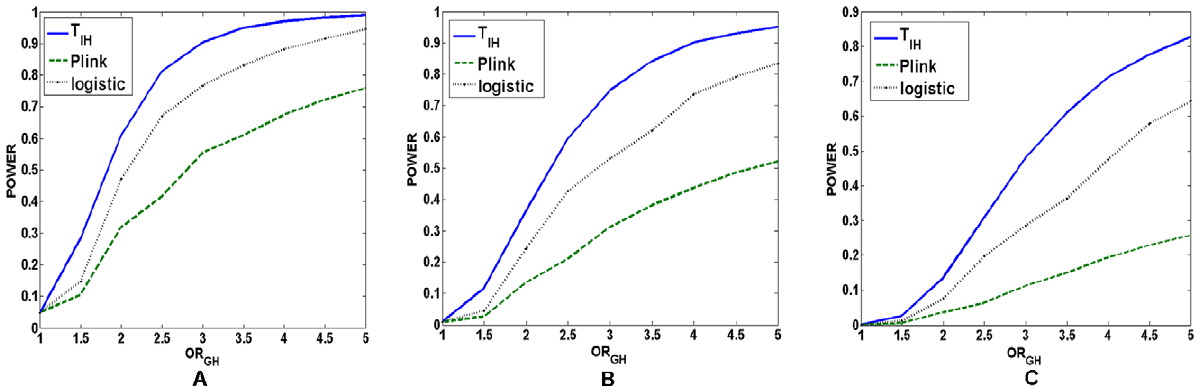
Figure 3. Power of the statistics for testing interaction between two linked loci under dominant disease model. (A) The power of the test statistic T IH , the ‘‘fast-epistasis’’ in PLINK and logistic regression analysis for testing interaction between two linked loci as a function of traditional odds-ratio OR GH under a two-locus dominant | dominant disease model, where the number of individuals in both the case and control groups is 1,000, the significance level is 0.05, and the odds-ratios at two loci were OR G ~ OR H ~ 1 . (B) The power of the test statistic T IH , the ‘‘fast- epistasis’’ in PLINK and logistic regression analysis for testing interaction between two linked loci as a function of traditional odds-ratio OR GH under a two-locus dominant | dominant disease model, where the number of individuals in both the case and control groups is 1,000, the significance level is 0.01, and the odds-ratios at two loci were OR G ~ OR H ~ 1 . (C) The power of the test statistic T IH , the ‘‘fast-epistasis’’ in PLINK and logistic regression analysis for testing interaction between two linked loci as a function of traditional odds-ratio OR GH under a two-locus dominant | dominant disease model, where the number of individuals in both the case and control groups is 1,000, the significance level is 0.001, and the odds-ratios at two loci were OR G ~ OR H ~ 1 .